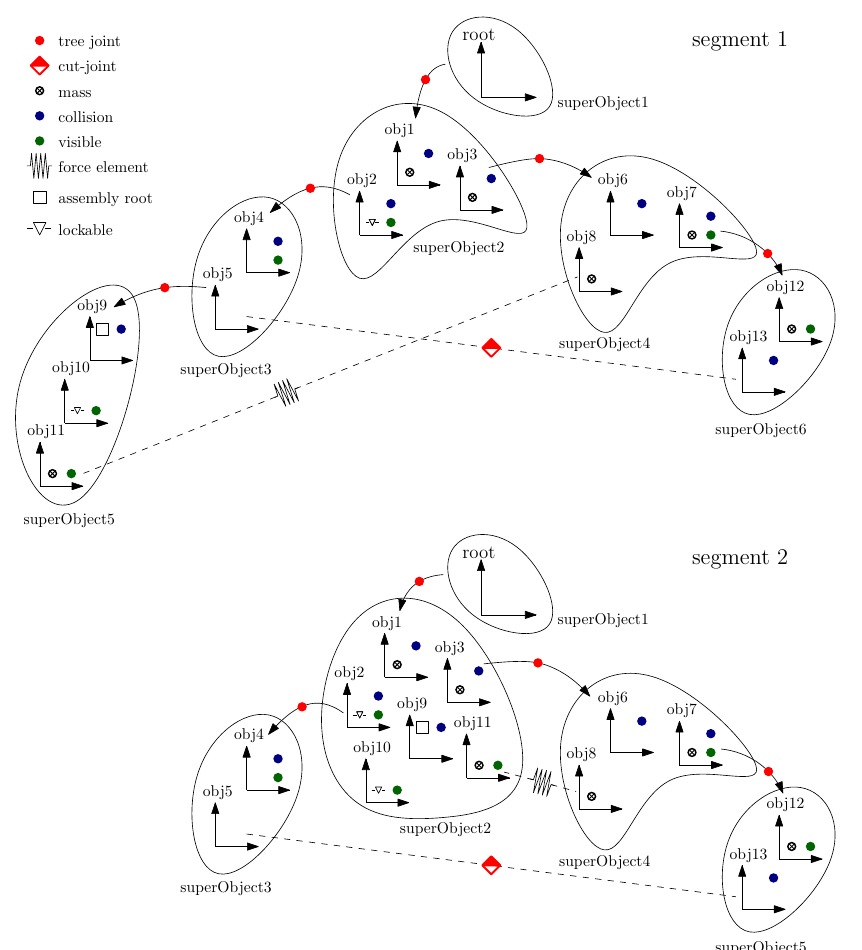
Internal execution scheme at initialization ( segment 1 ) and after re-initialization ( segment 2 ). ( Segment 1 ): Fourteen Object3Ds with different properties are defined: They are al- lowed to collide, can have a mass, are visible and/or can be connected by force elements. They are grouped into six super-objects that are disjunct via tree- and cut-joints; see [33]. SuperObject5 is an assembly with a lockable Object3D (obj10). Only the assembly root (obj9) is allowed to change joints and states during simulation. SuperObject2 is able to interact with this assembly via its rigidly attached locking mechanism (obj2). ( Segment 2 ): A full restart is triggered with ActionAttach(..., obj10, obj2) to initialize the second segment if both locking mechanisms (obj10 and obj2) are close to each other with negligible relative velocity. The lockable obj10 identifies its assembly root, which is obj9. The joint and states of the assembly root obj9 are removed, and all Object3Ds of the assembly are attached to superObject2. This results in five rigidly attached super objects after